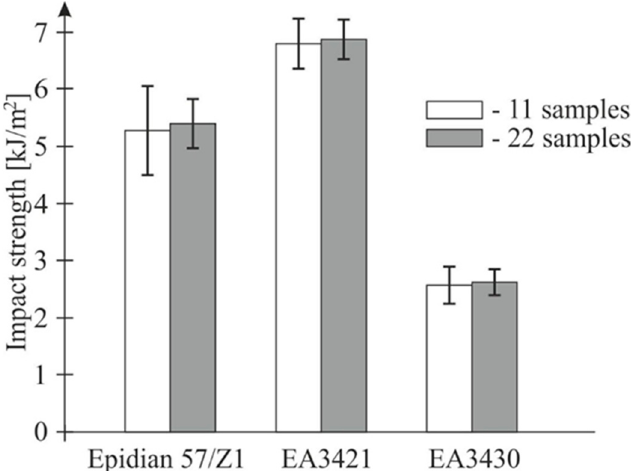
Figure 2. Average impact strength of the three adhesives and a standard deviation of the eleven-piece and twenty-two-piece batch (10 J hammer, speed of 3.81 m/s) .